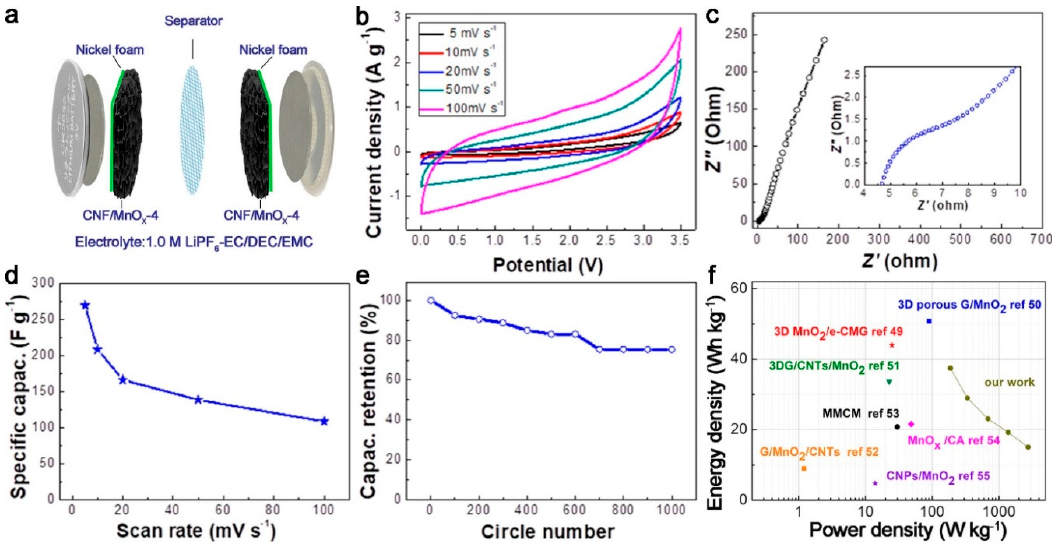
Figure 7. Electrochemical measurement of the CNF/MnO x -4 based symmetric supercapacitor: ( a ) Schematic illustration of the CNF/MnO x -4-based symmetric supercapacitor; ( b ) CV curves obtained at different scan rates; ( c ) Nyquist plots; ( d ) Specific capacitance vs. scan rate; ( e ) Cyclic stability at a charge–discharge current density of 2 A g − 1 for 1000 cycles; ( f ) Ragone plot.